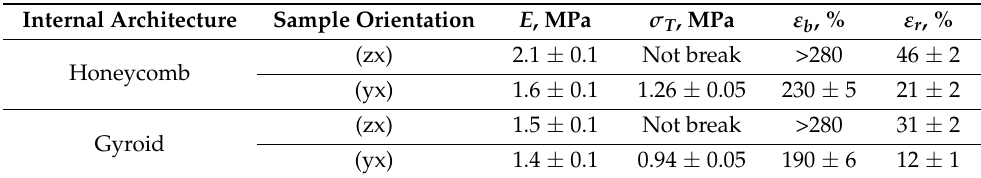
Figure 3. Representative stress–strain curves of lattice flexible TPU under tension. ( a ) honeycomb, ( b ) gyroid architecture. Table 1. Mechanical properties of lattice flexible TPU. Tensile test.